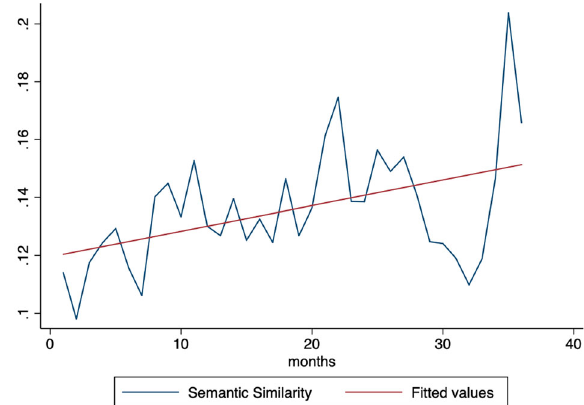
Fig. 3 The semantic similarity between explicitly anti-coal tweets using the hashtag #StopAdani and general tweets related to Adani Carmichael has increased steadily between March 2017 and February 2020. Semantic similarity between Adani tweets and #StopAdani tweets,